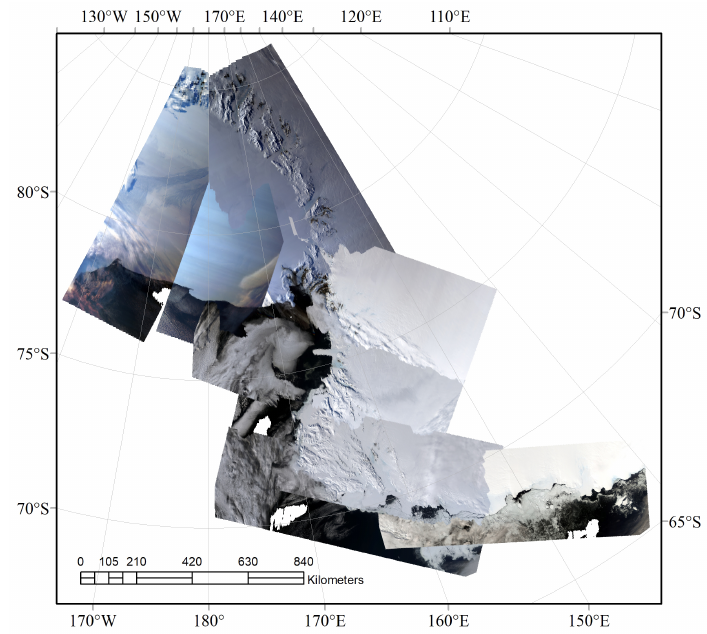
Figure 2. Example mosaic result for a group of HY-1C images of